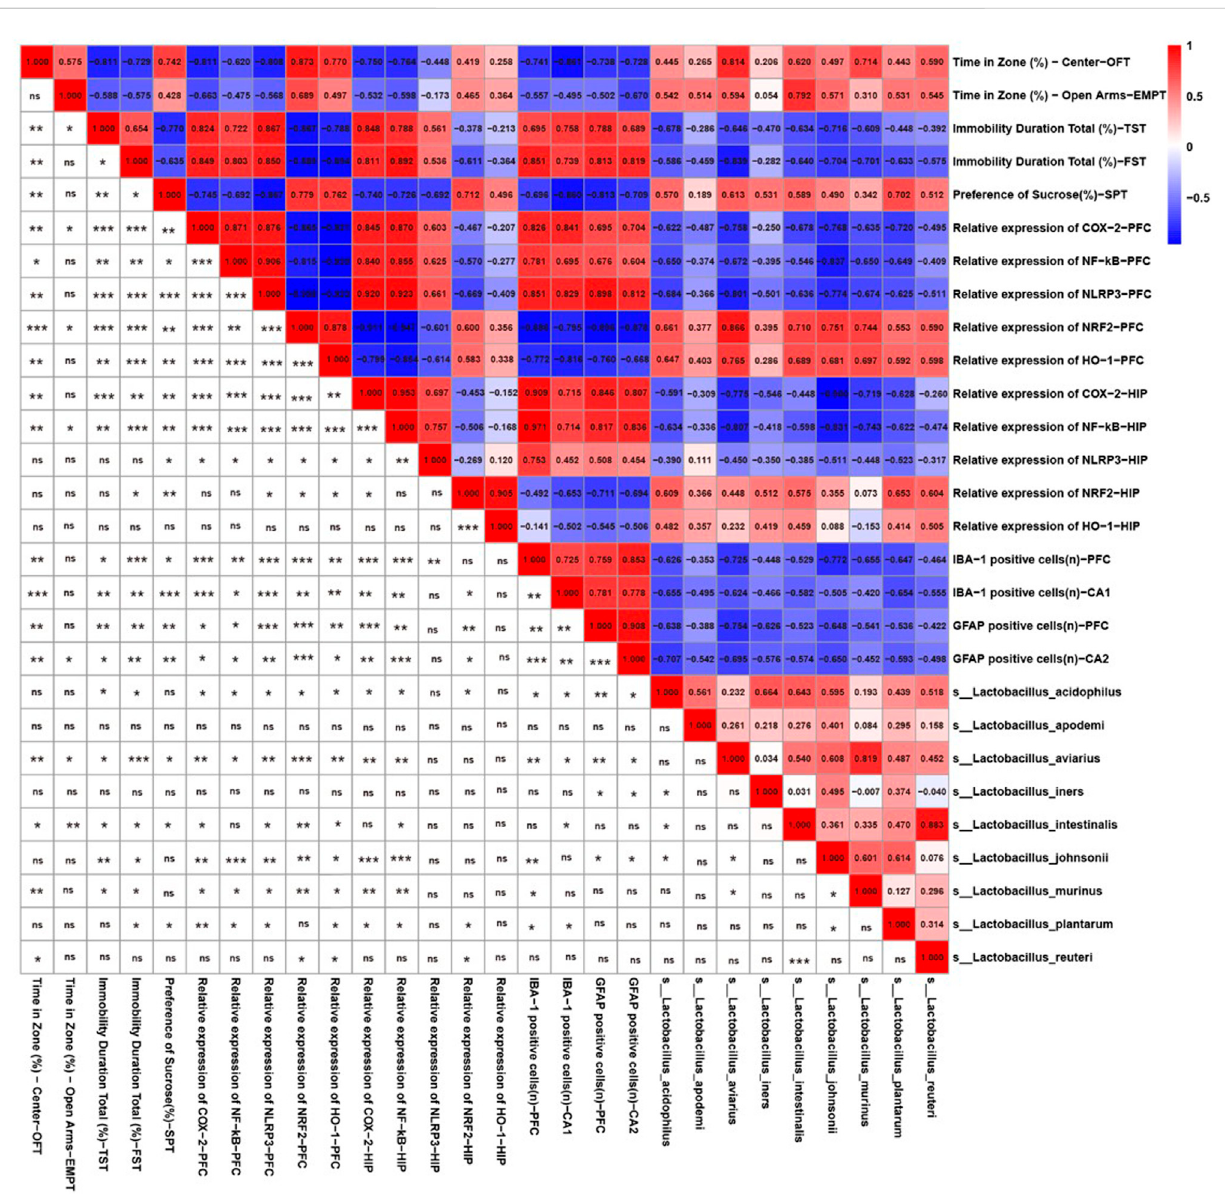
FIGURE 5 Behaviorandneuroin fl ammation-relatedindicatorspositively/negativelycorrelatedwiththerelativeabundanceof Lactobacillus species. Spearman correlations among Lactobacillus species, depression-like behaviors, and neuroin fl ammation-related indicators. Numbers in the upper right area represent values ofthecorrelationcoef fi cient;symbolsinthelower leftarea representtheresults ofthecorrelationand signi fi cance test.* p < 0.05, ** p < 0.01, *** p <